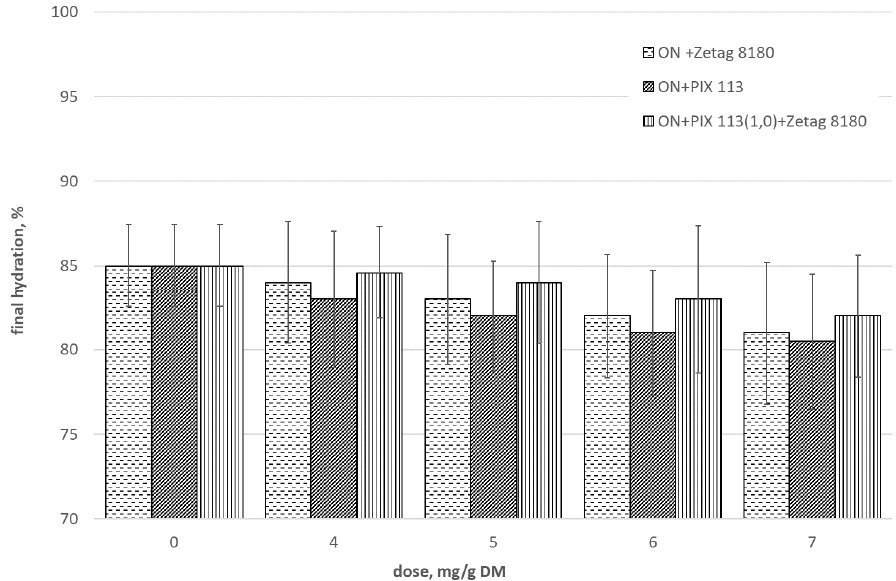
Figure 5. Effect of the dose of selected chemicals on the final hydration of prepared sludge (A 1 = 15.25 µm).